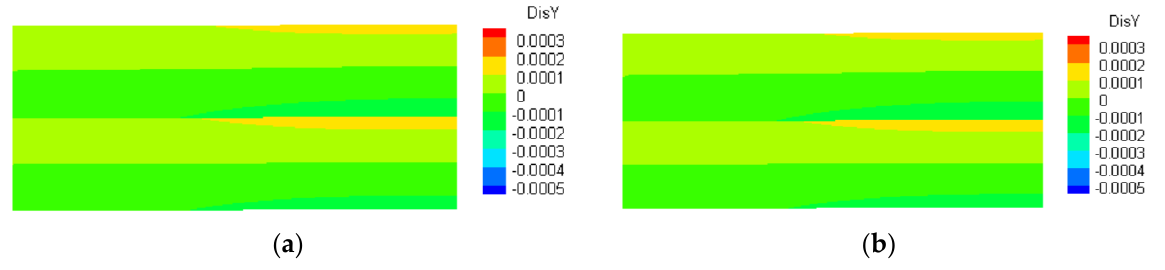
Figure 8. The distribution of displacement in Z-direction. ( a ) SBFEM. ( b ) ANSYS. Figure 7. The distribution of displacement in Y-direction. ( a ) SBFEM. ( b ) ANSYS. Figure 7. The distribution of displacement in Y-direction. ( a ) SBFEM. ( b ) ANSYS. Figure 7. The distribution of displacement in Y-direction. ( a ) SBFEM. ( b ) ANSYS. Figure 7. The distribution of displacement in Y-direction. ( a ) SBFEM. ( b ) ANSYS.